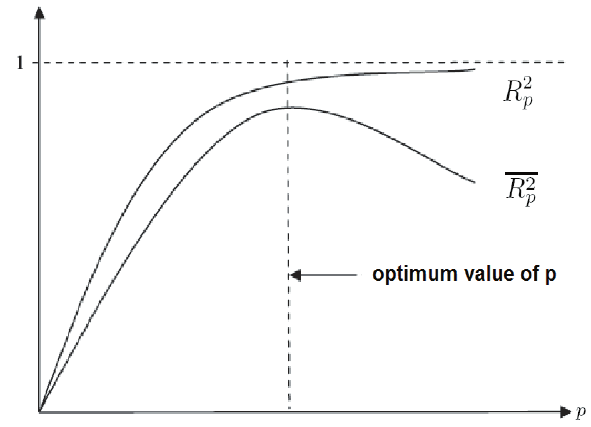
Fig. 2. Curve of R 2